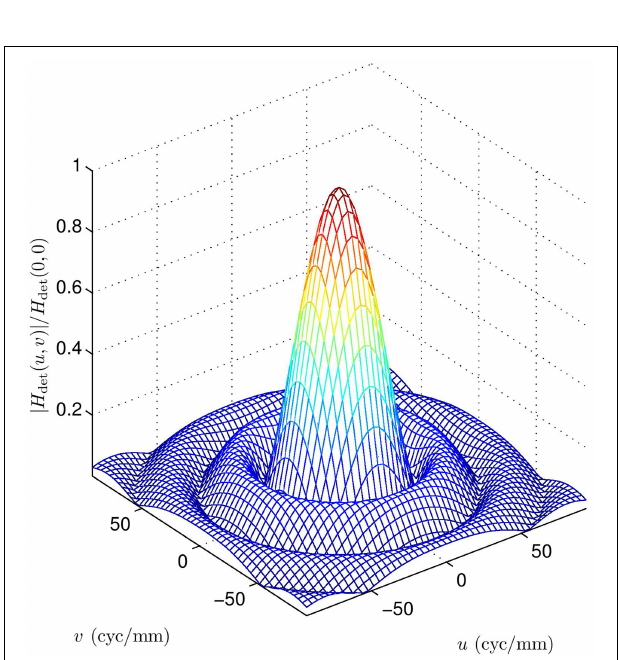
FIGURE 8 | Circular detector MTF for detector element diameter b = b 1 = b 2 = 30 μ m.